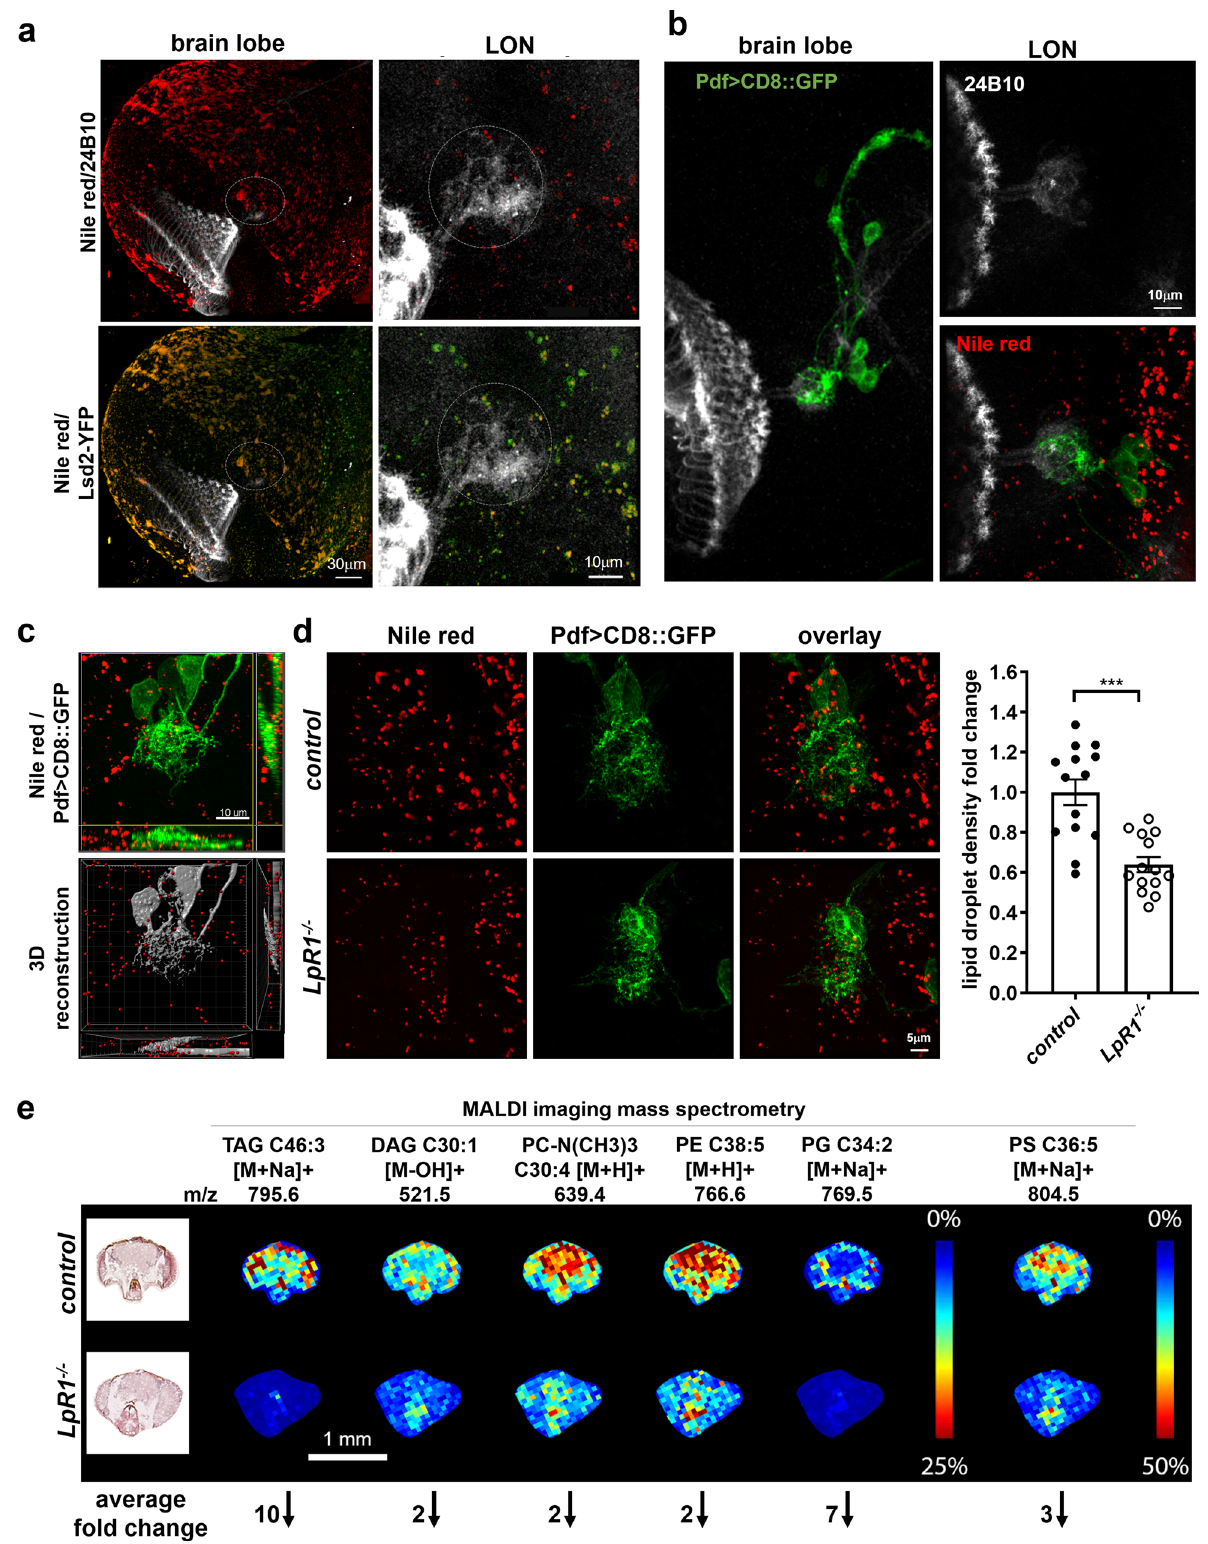
GLaz interacts with LpR1-short in the larval brain . Our studies demonstrated that both neuronal expression of LpR1-short and astrocyte expression of GLaz are required for the normal devel- opment of LNv dendrites and brain lipid homeostasis. Next, we sought to examine the physical and functional interactions between these two